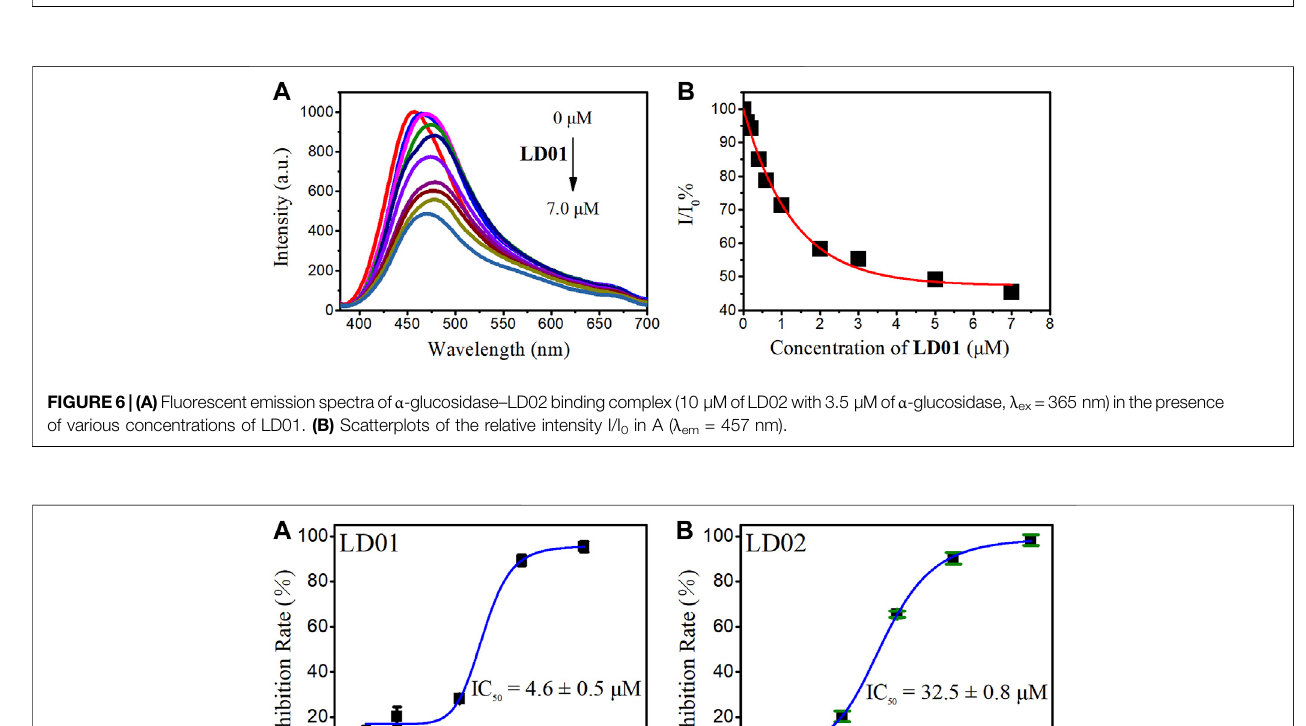
FIGURE 5 | (A) Fluorescence spectra of LD02 (10 μ M) in the presence of various species: α -glucosidase ( α -Glu) (3.5 μ M), GOD (3.5 μ M), TKY (3.5 μ M), PEP (3.5 μ M), Cys (1 mM), GSH (1 mM), Lys (1 mM), Ca 2+ (1 mM), Cu 2+ (1 mM), Fe 3+ (1 mM), Mg 2+ (1 mM), and Zn 2+ (1 mM) in PBS buffer. (B) The plot of (I-I 0 )/I 0 in A ( λ ex = 365 nm, λ em = 457 nm).